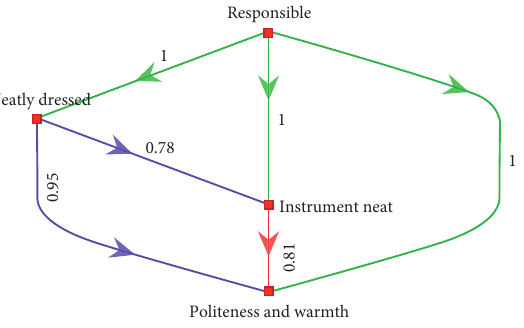
Figure 7: Credal ranking for the “Traits” dimension.